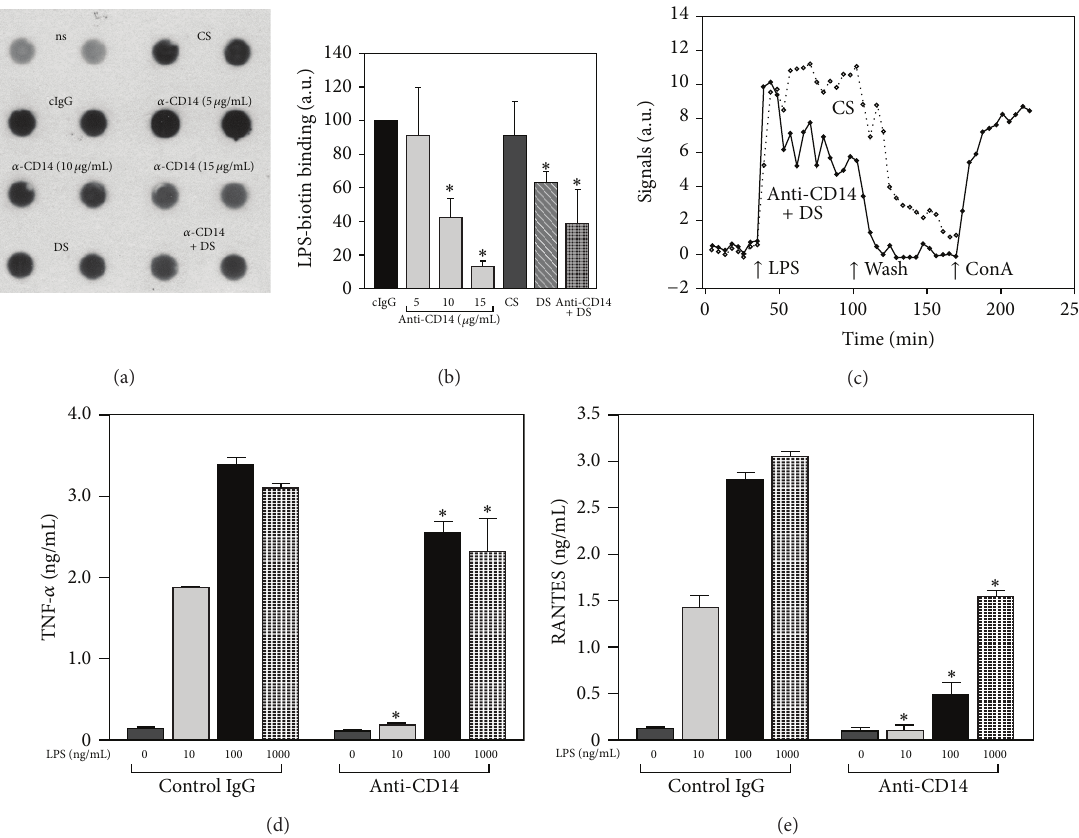
Figure 5: Disparate requirements for CD14 participation in the binding of high doses of LPS and production of TNF- 𝛼 in J774 cells.(a, b) Binding of sLPS-biotin to the surface J774 cells. Cells were preincubated with 0.05% NaN 3 (30min, 37 ∘ C) and either left untreated (ns) or supplemented with 5, 10, or 15 𝜇 g/mL of the anti-CD14 antibody or 10 𝜇 g/mL isotype matched control IgG (cIgG) or 50 𝜇 g/mL dextran sulfate (DS) or 50 𝜇 g/mL chondroitin sulfate (CS) or a mixture of 5 𝜇 g/mL anti-CD14 antibody and 50 𝜇 g/mL dextran sulfate for 30min (37 ∘ C). Subsequently, 1 𝜇 g/mL of sLPS-biotin was added to the cultures for 1h in the presence of 0.05% NaN 3 . (a) Dot-blot analysis of sLPS-biotin in cell homogenates. (b) Densitometric analysis of dot-blots exemplified in (a). Data are mean ± SEM from three experiments. (c) LigandTracer real-time analysis of the binding and internalization of sLPS-AF488. Cells were preincubated for 15min at 37 ∘ C with a mixture of 10 𝜇 g/mL anti-CD14antibodyand50 𝜇 g/mLdextransulfate(DS)orwith50 𝜇 g/mLchondroitinsulfate(CS)andtransferredintotheLigandTracer.After 30 min of the baseline setting (37 ∘ C), cells were exposed to 3 𝜇 g/mL of sLPS-AF488 for 1h (association phase), washed to remove the unbound LPS, and monitored for another 1h to measure retention of sLPS-AF488 in cells. Traces with open symbols and closed symbols reflect sLPS- AF488 binding and internalization in CS-treated and anti-CD14/DS-treated cells, respectively. Concanavalin A-FITC (100 𝜇 g/mL; ConA) was added to the anti-CD14/DS-treated culture for 40 min to ensure that the cells were still adherent. (d, e) Production of TNF- 𝛼 (d) and RANTES (e) in cells pretreated with 10 𝜇 g/mL of the anti-CD14 antibody or isotype-matched control rat IgG2b and stimulated with 10–1000ng/mL of sLPS. Data are mean ± SEM from three experiments. ∗ Significantly different from cells exposed to control